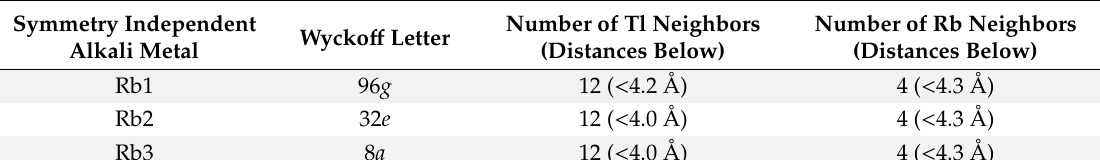
Table 3. Surrounding atoms of the symmetry inequivalent potassium positions in Rb 17 Tl 41 (space group Fd- 3 m ).